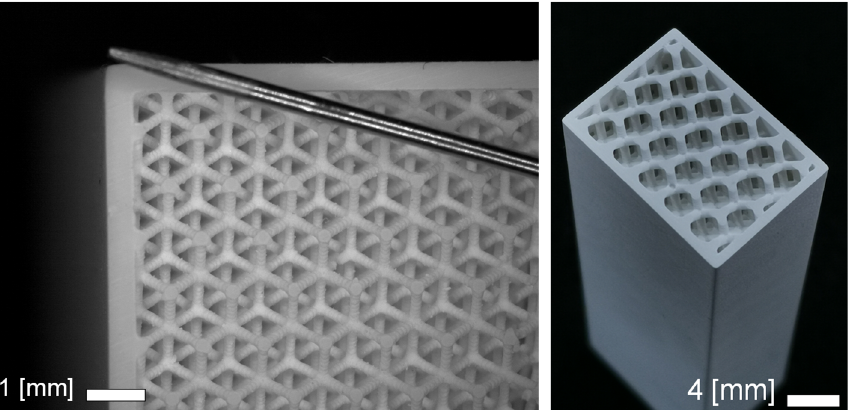
Figure 6. ( left ): 3D-printed closed-walls lattice, the base cells correspond to a rotated cube with a struts diameter of 0.20 mm, a cell length of 1 mm, and a wall thickness of 0.55 mm. As a reference, a sewing needle with a diameter of about 0.4 mm is placed on the component. ( right ): 3D-printed and sintered closed-walls lattice in its final configuration, the base cells correspond to a rotated cube with a struts diameter of 0.55 mm and a cell length of 2 mm.